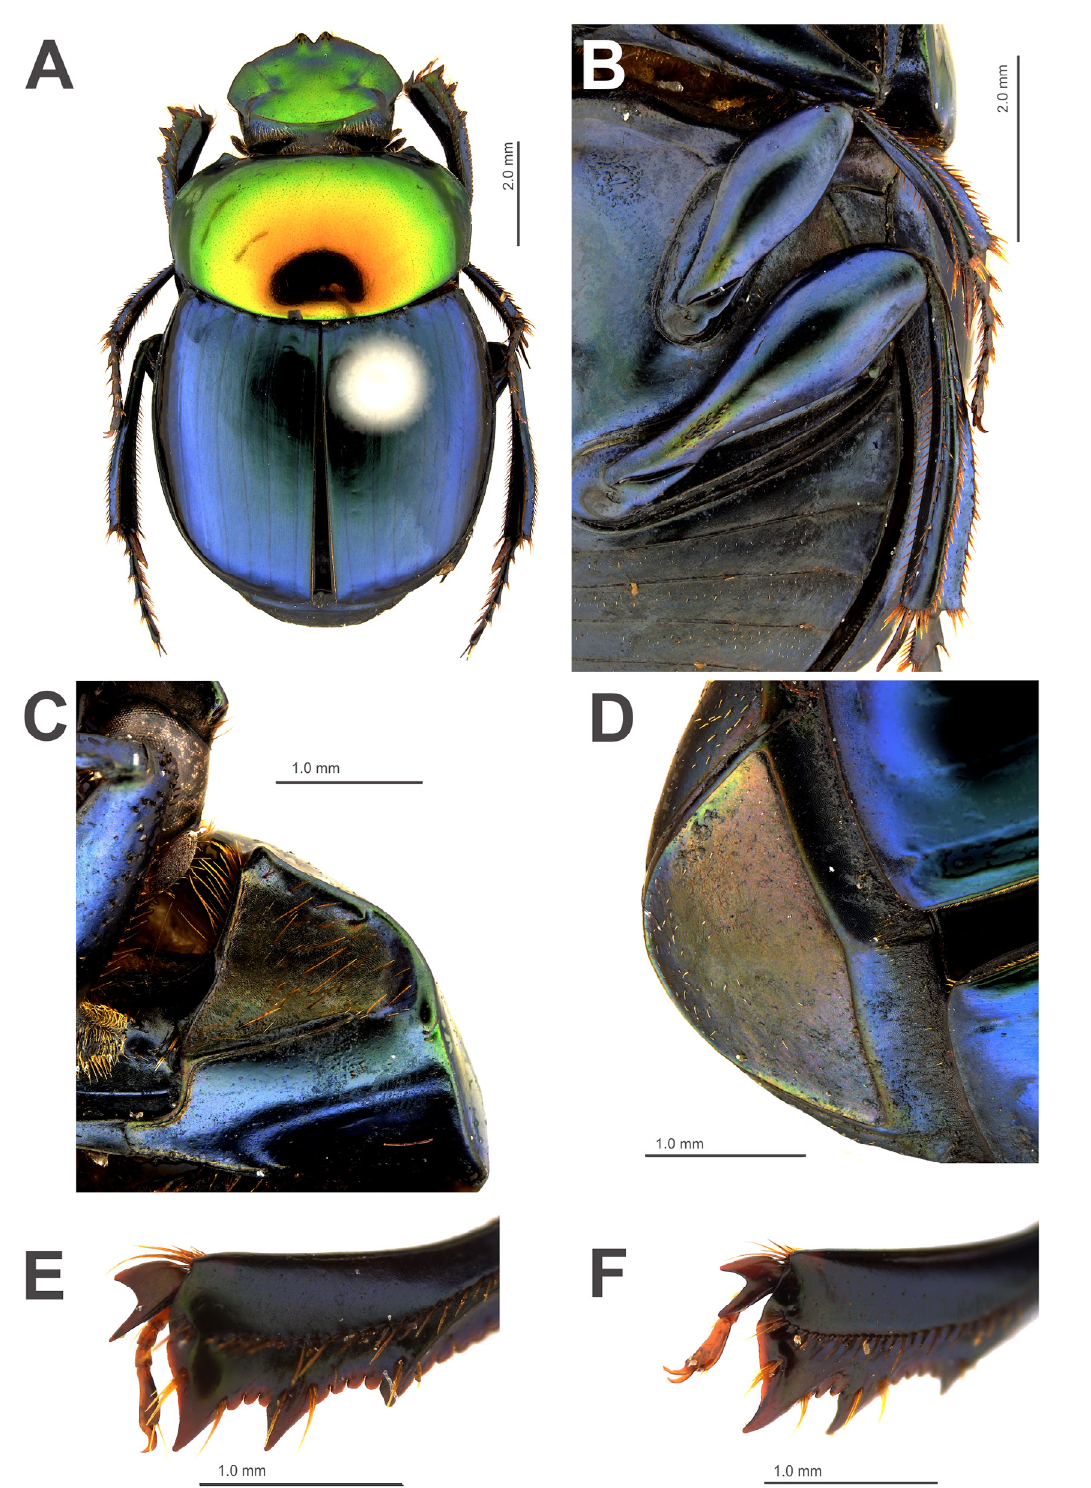
Fig. 5. Canthon ( Peltecanthon ) splendidus Schmidt, 1922. A–E . Male, Minas Gerais, Barão do Cocais, Mina Gongo Soco (CEMT). A . Dorsal habitus. B . Ventral surface of meso- and metafemora. C . Transverse carina in the hypomeron. D . Carina in the margin between pygidium and propygidium. E . Male protibial spur. F . Female protibial spur, Espírito Santo, Vargem Alta